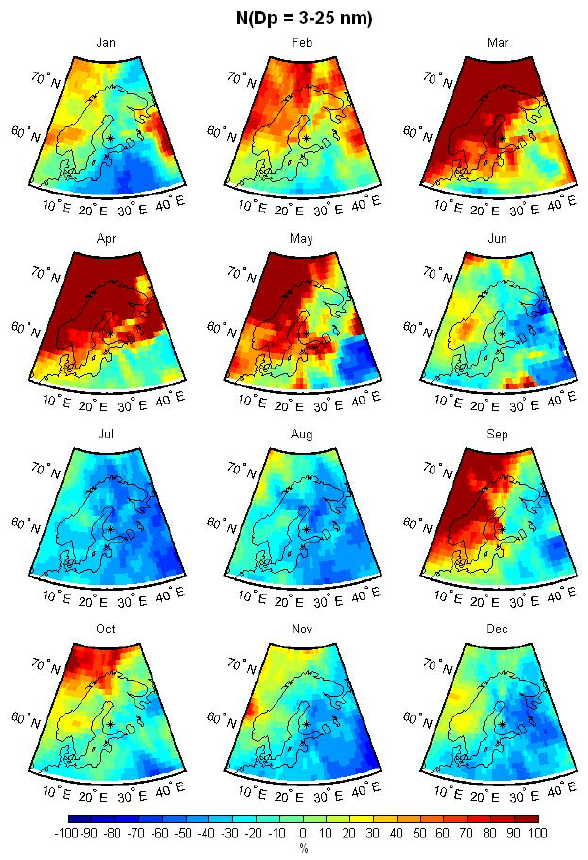
Fig. 3. Deviation from measured average number concentration of nucleation mode particles ( D p = 3–25nm) in Hyyti¨al¨a according to transport directions. Monthly concentration fields are produced for years 1996–2008. Fields are normalized to the geometric mean con- centration (239 cm − 1 ) of the whole measurement period. Hyyti¨al¨a is marked with a